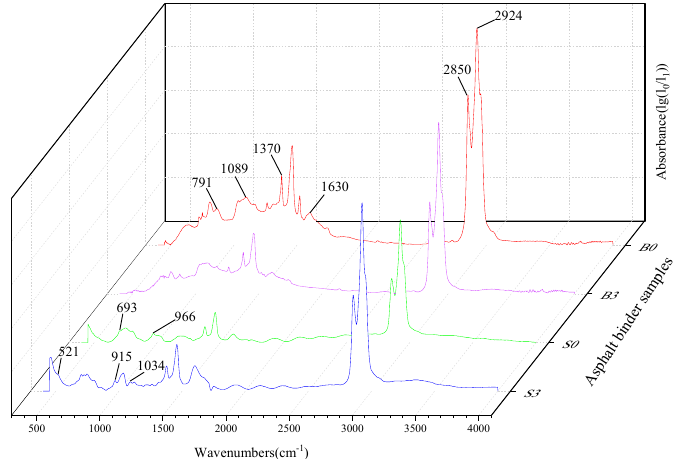
Figure 5. Fourier transform infrared (FTIR) test results of asphalt binder. In the base asphalt, the absorption peaks at 2924 cm − 1 and 2850 cm − 1 are characteristic peaks for alkane C-H asymmetric and symmetric vibrations, respectively. The absorption peak at 1630 cm − 1 characterizes the conjugated double bond C=C stretching vibration. Notably, 1370 cm − 1 is a characteristic peak for aliphatic C-H in-plane bending vibration, while 1089 cm − 1 represents the C-O stretching vibration. The characteristic peak of 791 cm − 1 represents the olefin C-H out-of-plane bending vibration. For the SBS asphalt binder, there are some differences between the modified asphalt and the base asphalt in the fingerprint region located in the 650–1100 cm − 1 region. The absorption intensities of the SBS asphalt binder are greater at 690–710 cm − 1 and 950–980 cm − 1 , and absorption peaks appear at 966 cm − 1 and 693 cm − 1 , which represent the out-of-plane C-H wobble vibrations on benzene rings and polybutadiene, respectively.